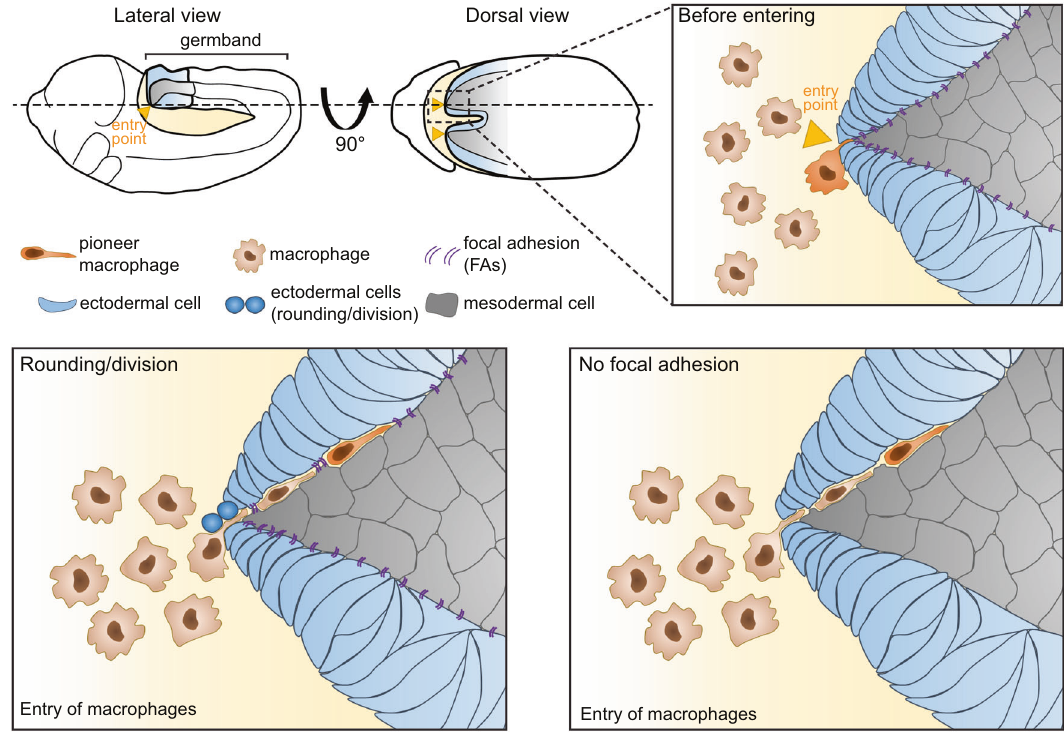
Fig. 1 Schematic illustration during macrophage invasion of the germband. Lateral and dorsal view of the Drosophila melanogaster embryo. The focal plane of the germband invasion (dashed line) is shown. The entry points (orange arrow) located at the junction of the ectoderm (cyan) and the mesoderm (gray) are depicted. Before invading the germband macrophages accumulate in front of the entry point. Upon rounding during ectodermal cell division at the entry point, the pioneer macrophage enters the tissue. In addition, lack of focal adhesions in the ectodermal layer permits macrophage invasion in absence of